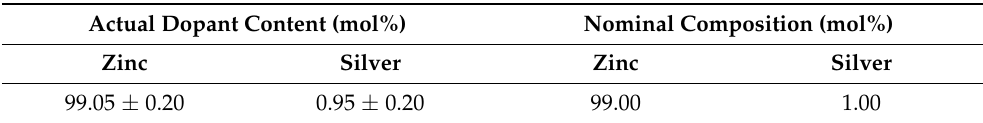
Table 2. Results of the analysis of the chemical composition of ZnO+1%Ag NPs. The method of analysis was energy-dispersive spectrometry (EDS). Actual Dopant Content (mol%)